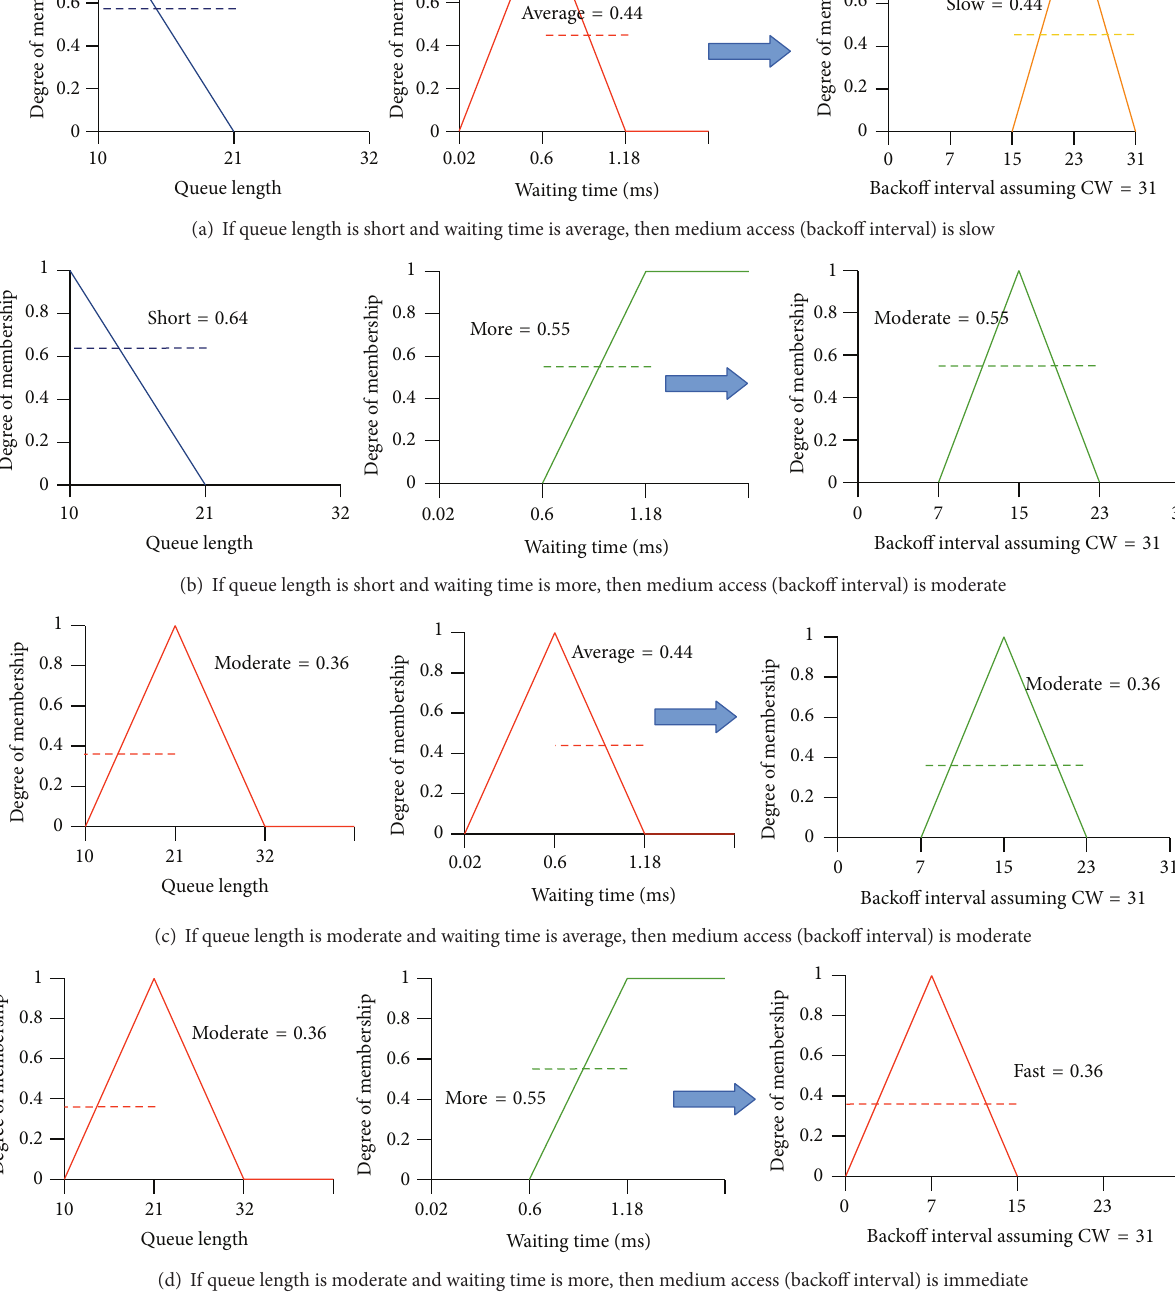
Figure 6: Evaluating the rule base with input parameters myqlen = 14 , mywt = 0.92 msec, CW = 31 , min 𝑄 𝑙 = 10 , max 𝑄 𝑙 = 32 , minWT = 0.02 msec, and max WT = 1.18